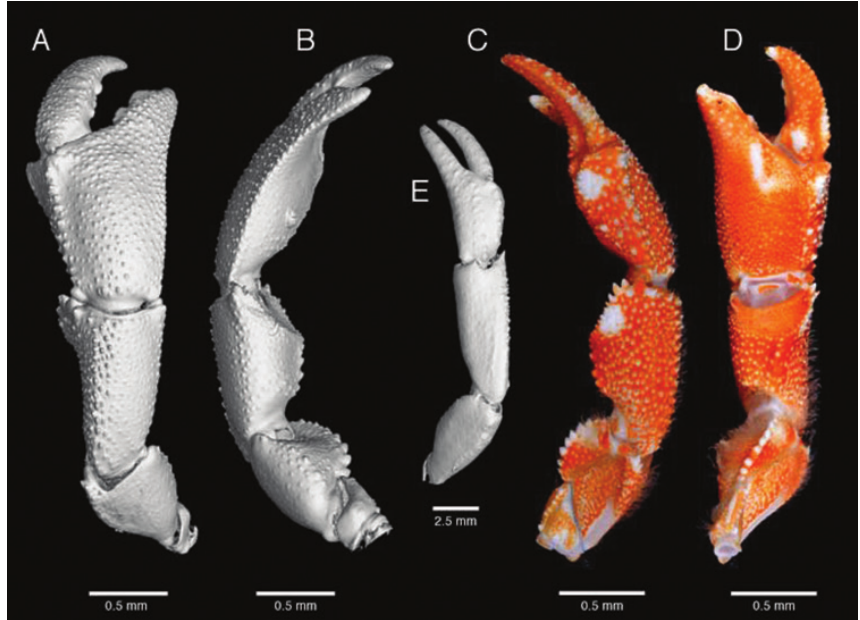
Figure 4. Paragiopagurus atkinsonae sp. n., South Africa, West Coast: A, B, E microCT scans, male holotype 7.0 mm, WCDSS2016 (USNM 1292083); C, D photographs, male paratype 6.8 mm, WCDSS2016 (SAMC MB-A066815). Right cheliped: A dorsal view B lateral view C mesial view D ven- tral view. Left cheliped: E dorsal